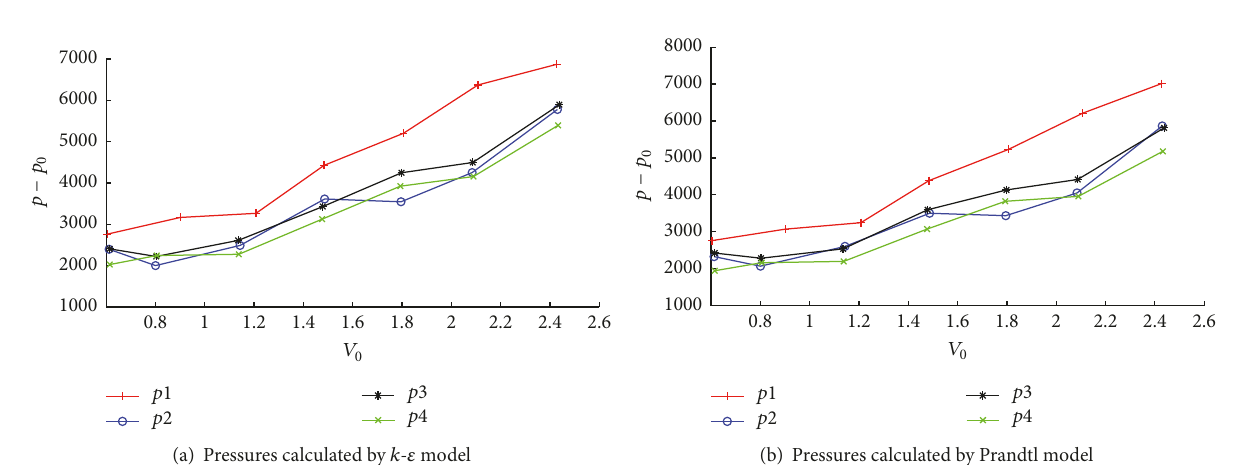
Figure 14: Numerical prediction of vertical slamming force.